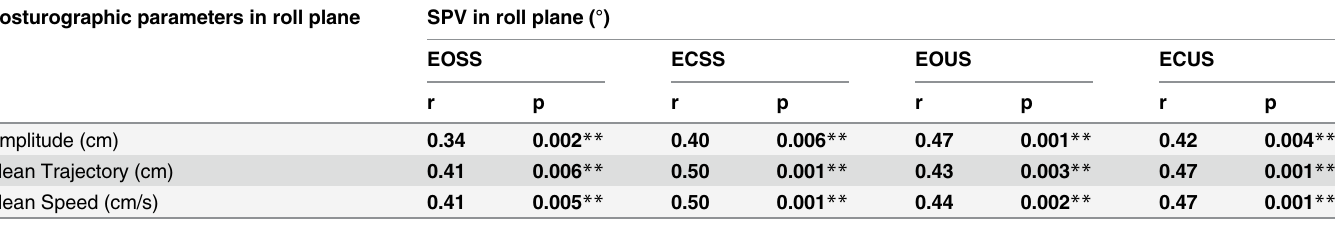
Table 3. Correlation between SPV and posturographic parameters in roll plane at sitting position. Posturographic parameters in roll